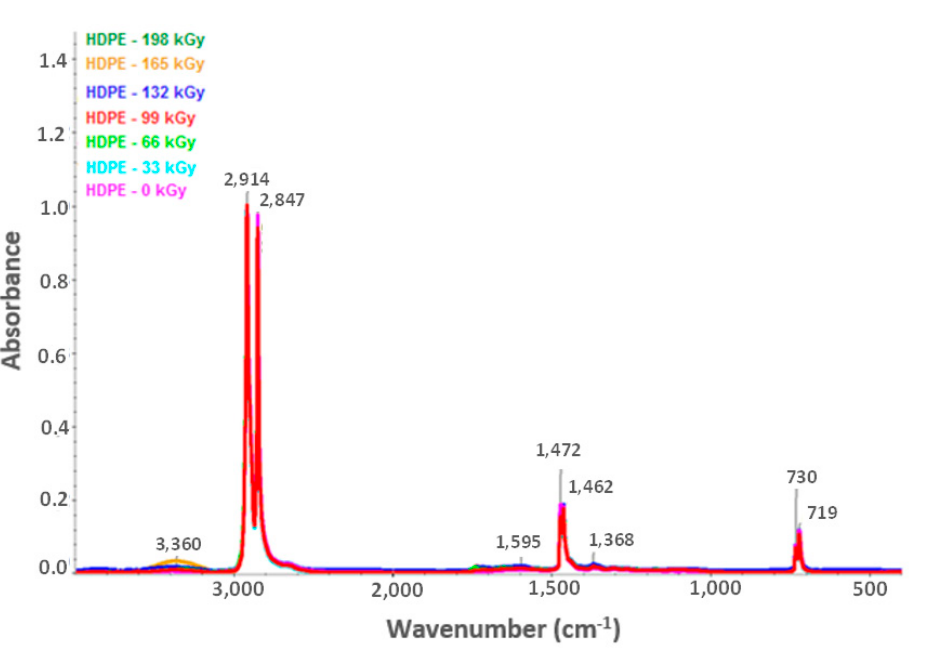
Figure 12. Infrared spectra of irradiated LDPE [29].